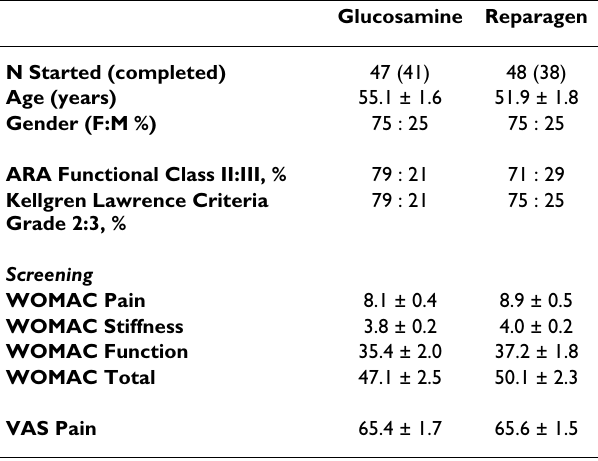
Table 1: Baseline characteristics of treatment groups Glucosamine